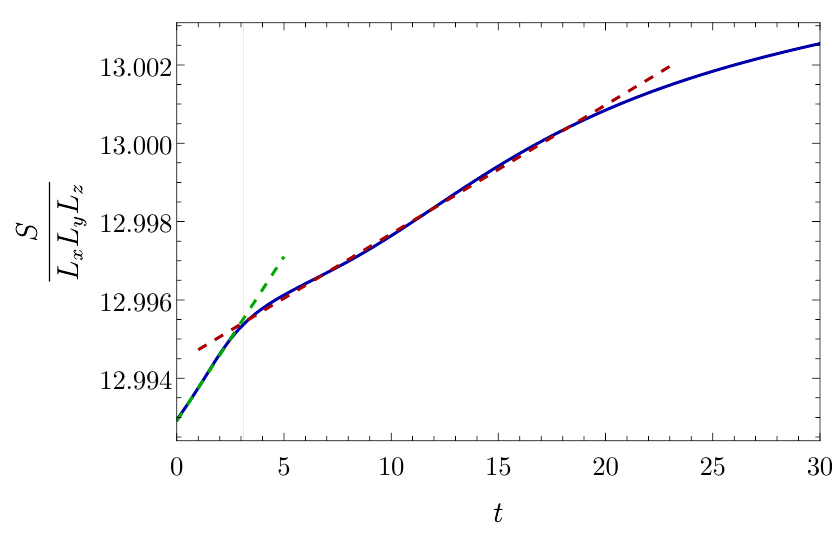
Figure 9 . Average entropy density as a function of time for a charged oblate blob collision with δx = 2 . The vertical gray line indicates the collision time t c ≈ 3 . 11 . The dashed lines are linear fits, whose slopes are (8 . 39 · 10 − 4 , 3 . 29 · 10 − 4 )